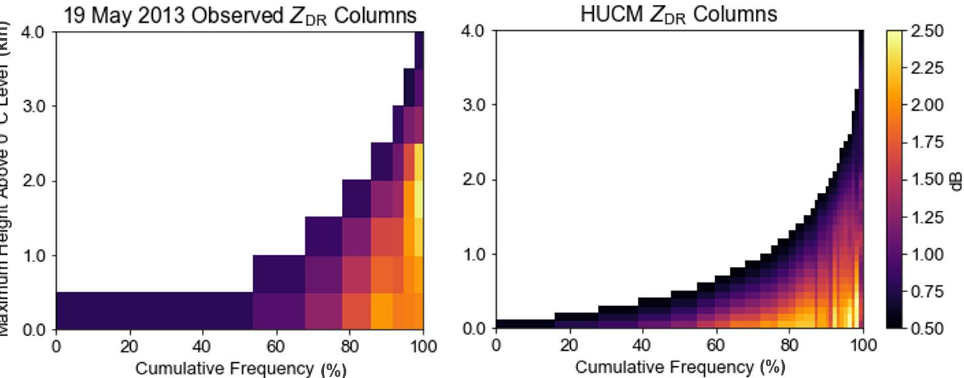
Figure 5. Cumulative histograms of Z DR column height ( left ) observed during Oklahoma tornadic storms on 19 May 2013 and ( right ) from an idealized storm simulated by the HUCM.